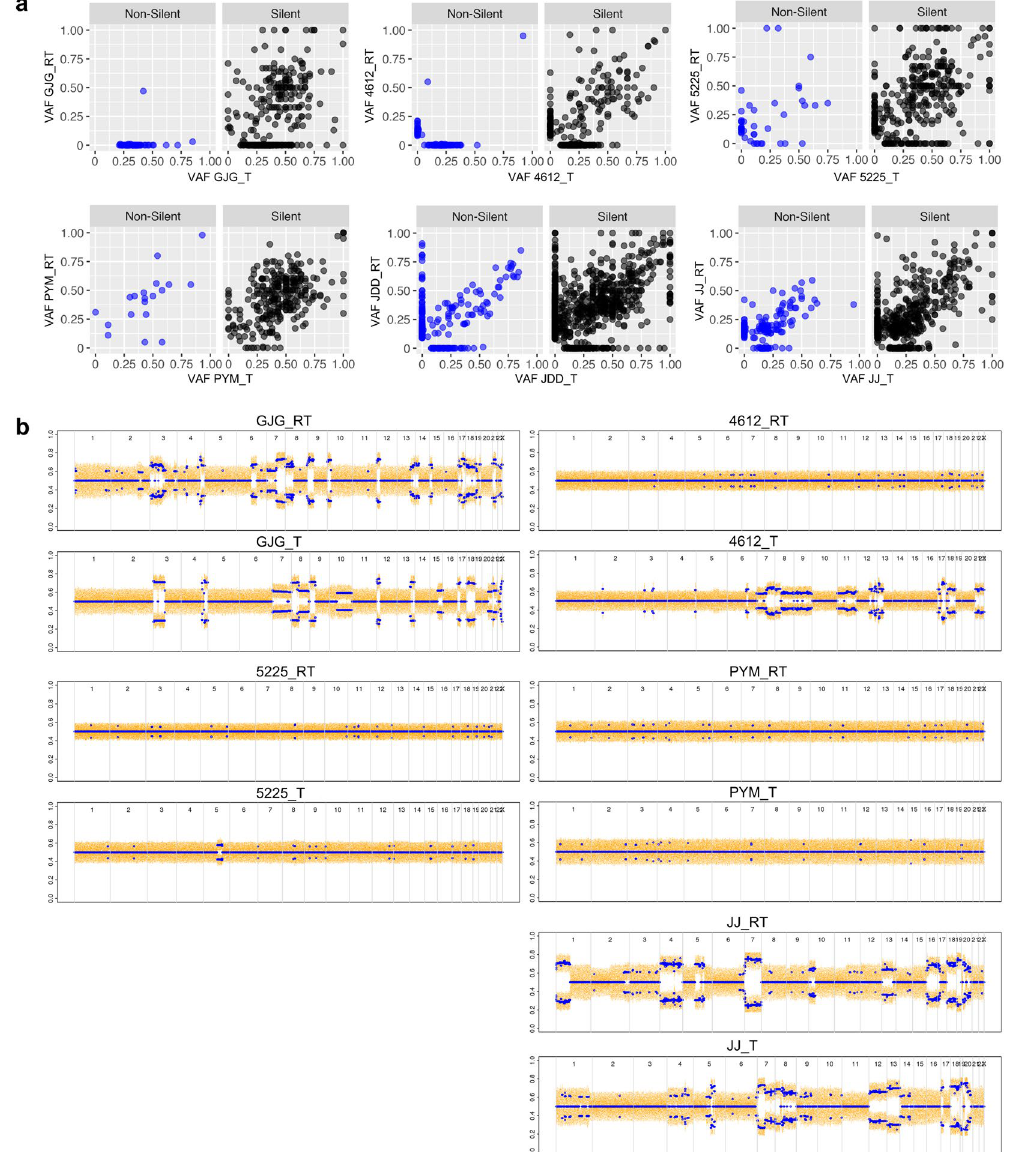
chromosome (1–22) of T and